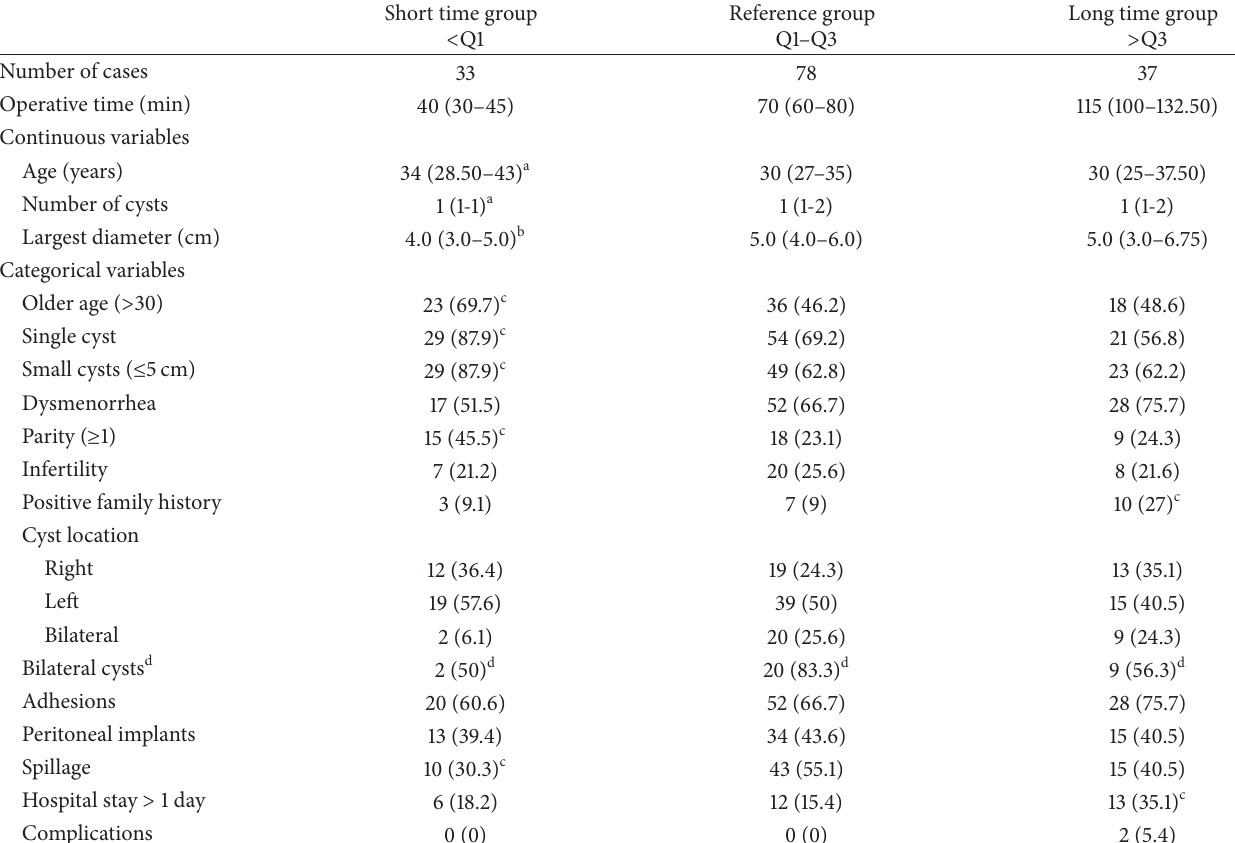
Table 2: Comparison between groups of cases with shorter, average, and longer operative time.